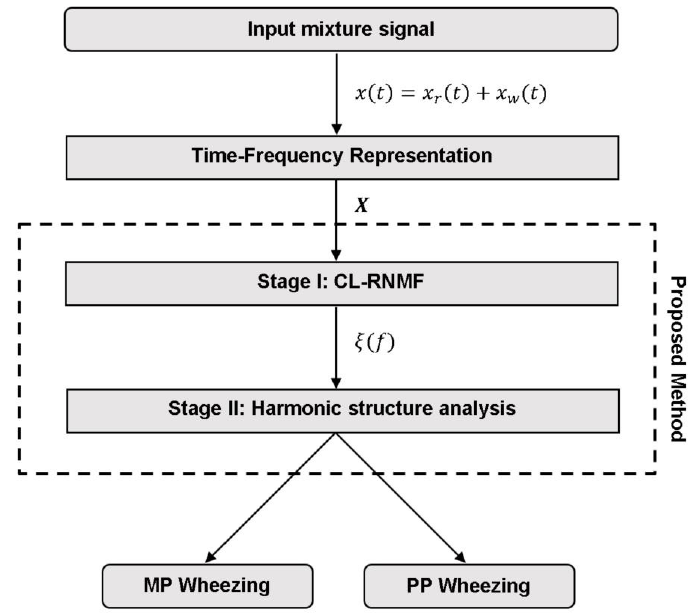
Figure 3. Flowchart of the proposed